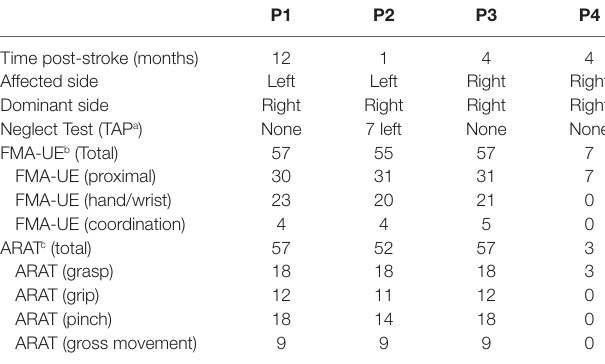
TaBle 1 | Baseline characteristics of four stroke